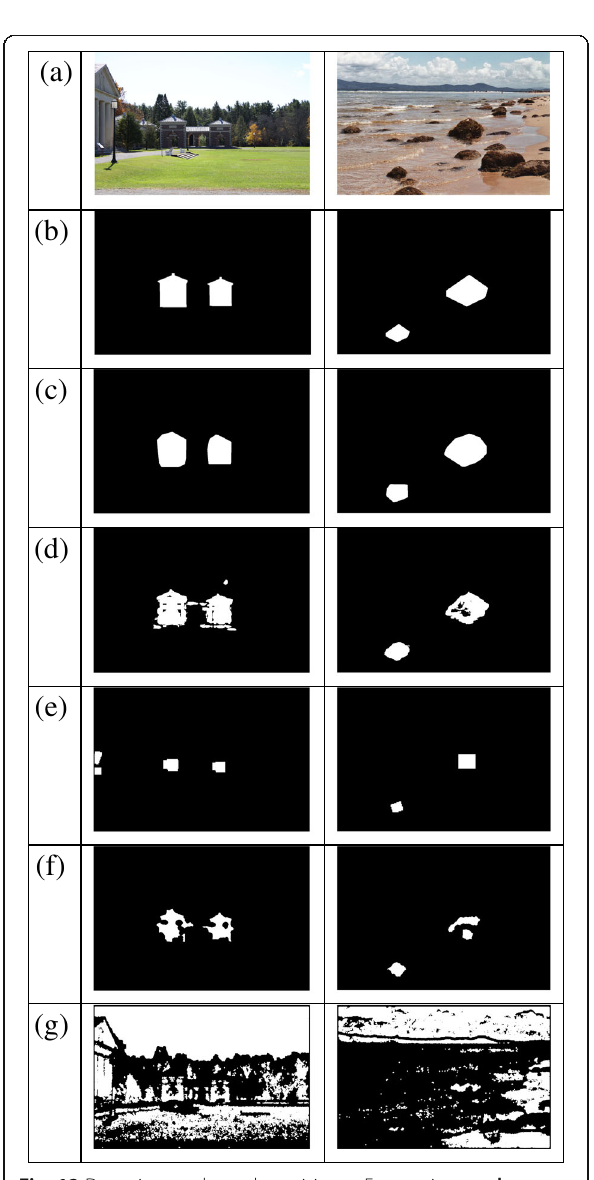
Fig. 12 Detection results under resizing. a Forgery images. b Ground truth. c Our proposed. d Amerini et al. [13]. e Silva et al. [16]. f Pun et al. [18]. g Li et al. [19]